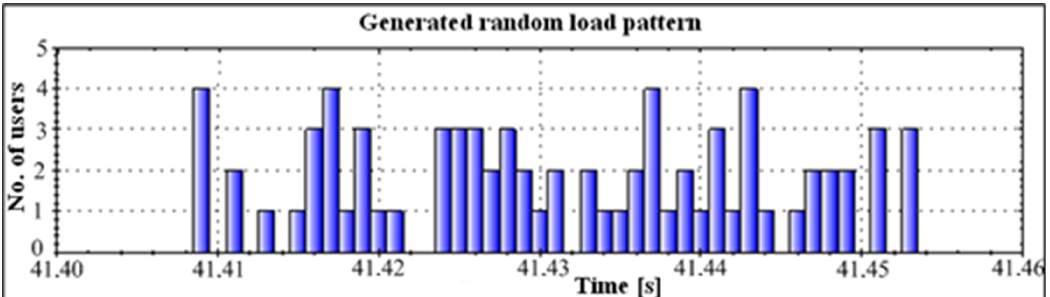
Figure 9. Generated random load pattern based on a normal distribution, defined by the parameters in Table 2. The number of users = 75.